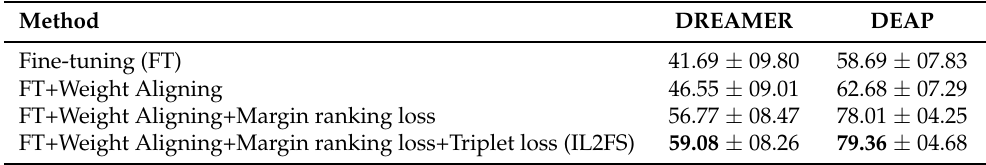
Table 5. Effect of each component of IL2FS on DREAMER and DEAP. The best results are in bold. Method DREAMER DEAP Fine-tuning (FT) 41.69 ± 09.80 FT+Weight